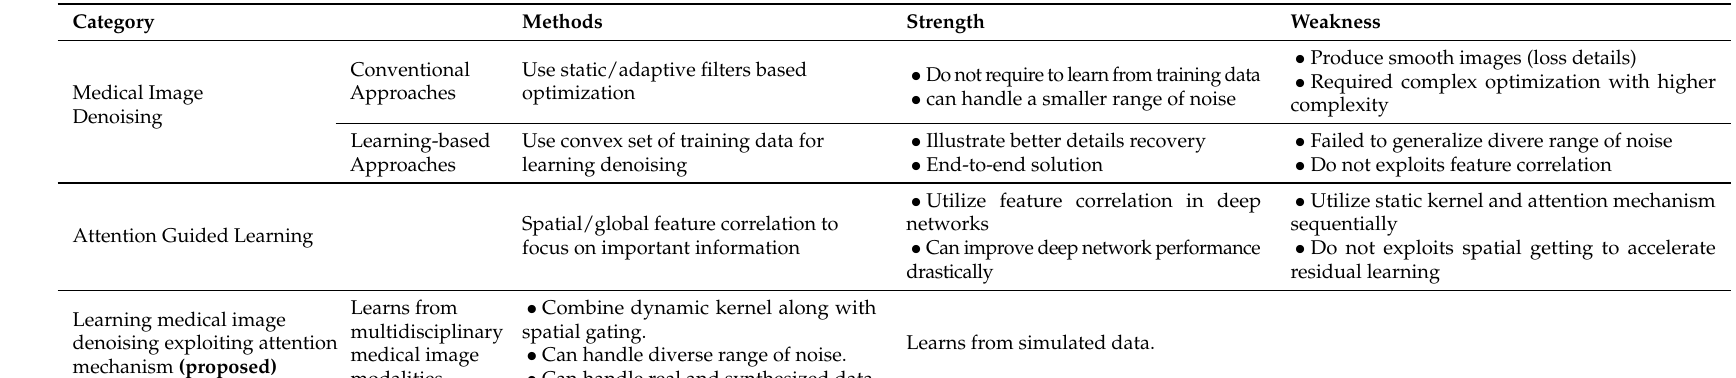
Table 1. A brief comparison between existing works and the proposed